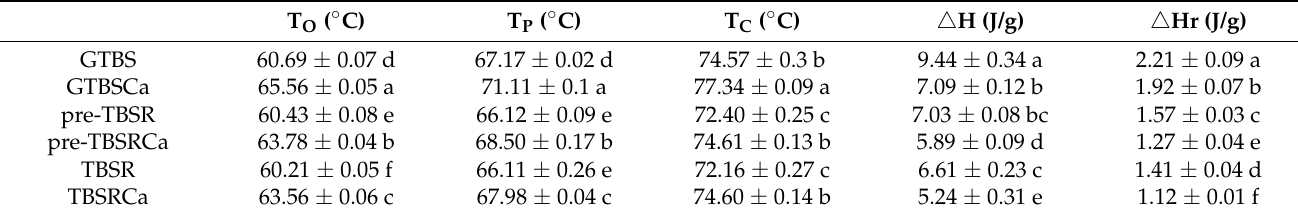
Table 2. Pasting and gelatinization property changes of